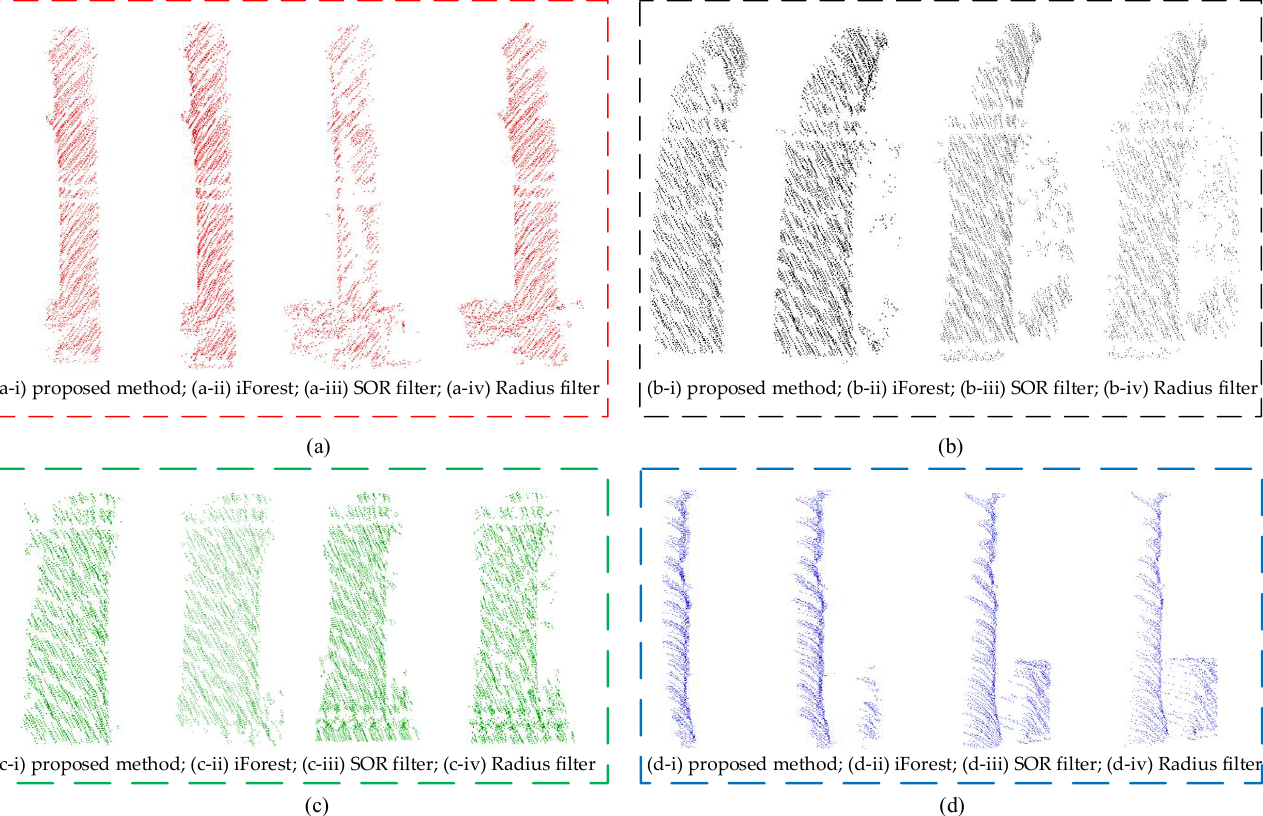
Figure 10. Denoising effect comparison: ( a – d ) The four denoising effects in Figure 6a–d.